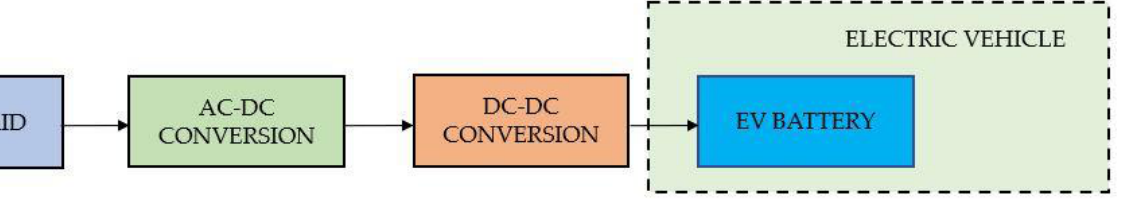
Figure 3. Block diagram schematic for off-board charging.